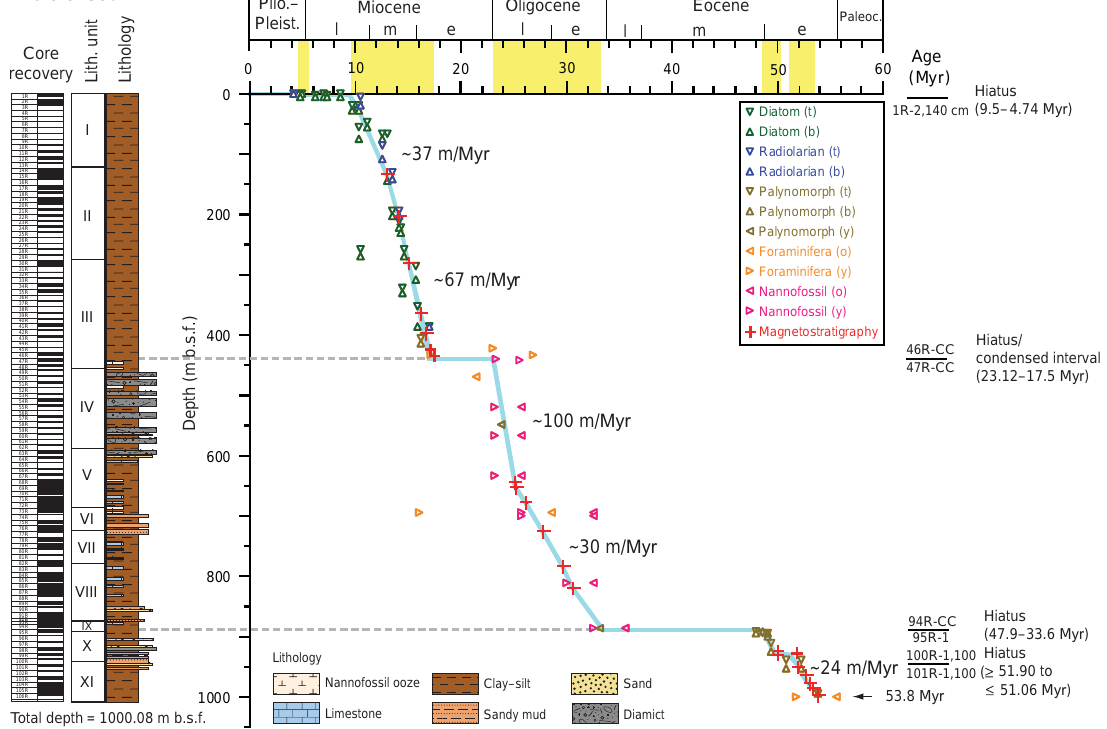
Figure 2. Age–depth plot and lithostratigraphic summary for Site U1356, after Tauxe et al. (2012) and Escutia et al.